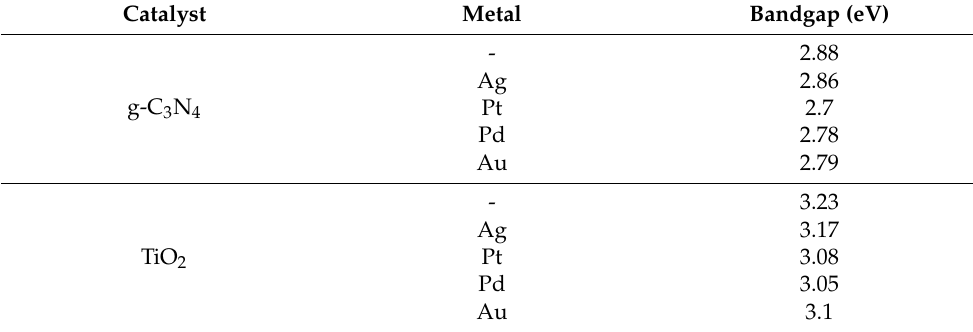
Table 1. Bandgap of the component-doped catalysts